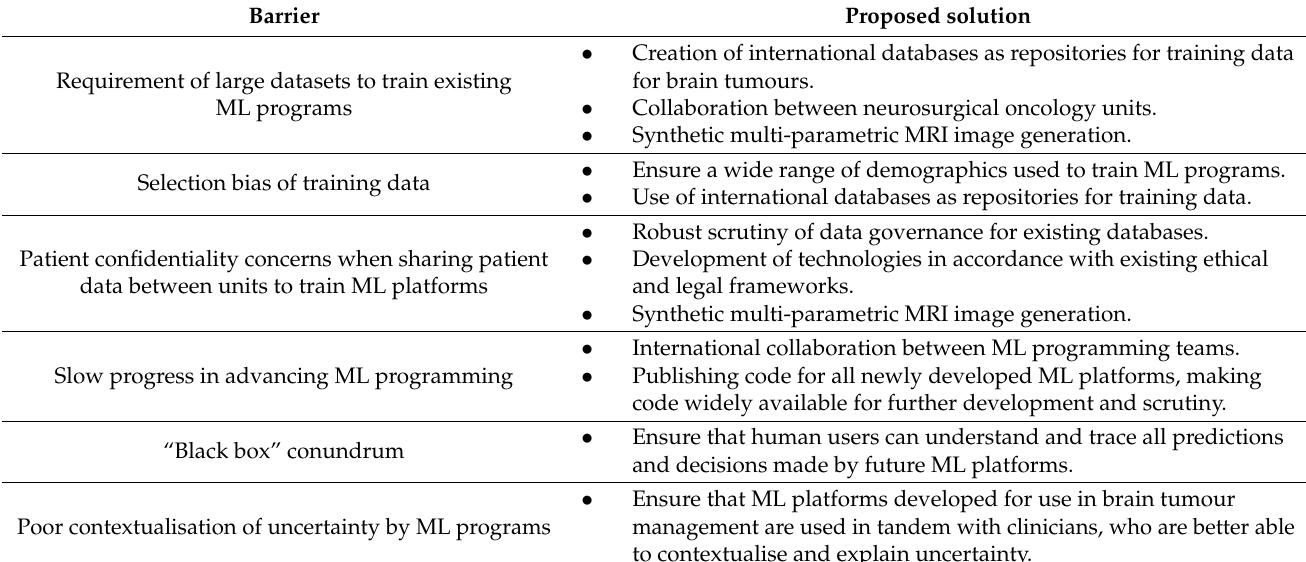
Table 1. Barriers and solutions for integration of AI into brain tumour surgery.